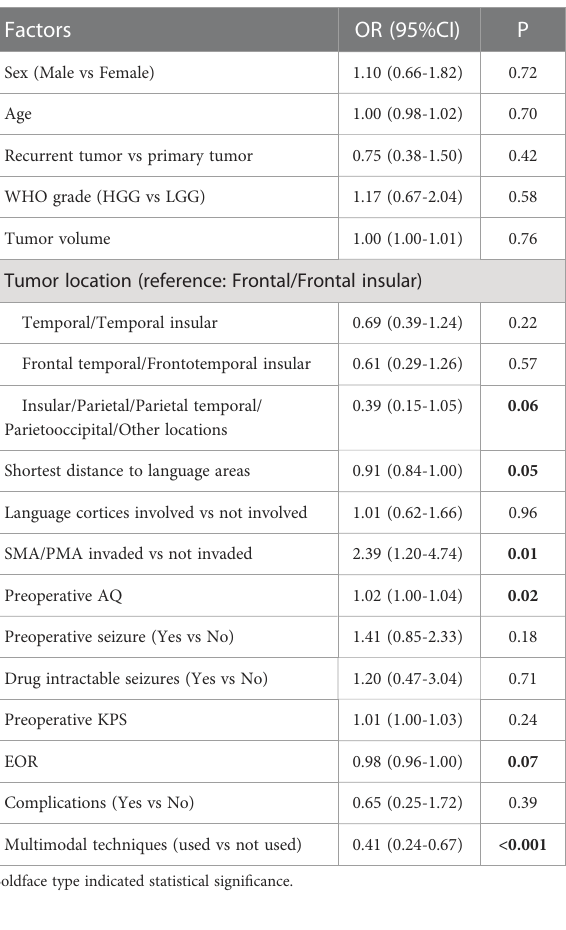
TABLE 6 Factors for permanent language de fi cit by univariate analysis.